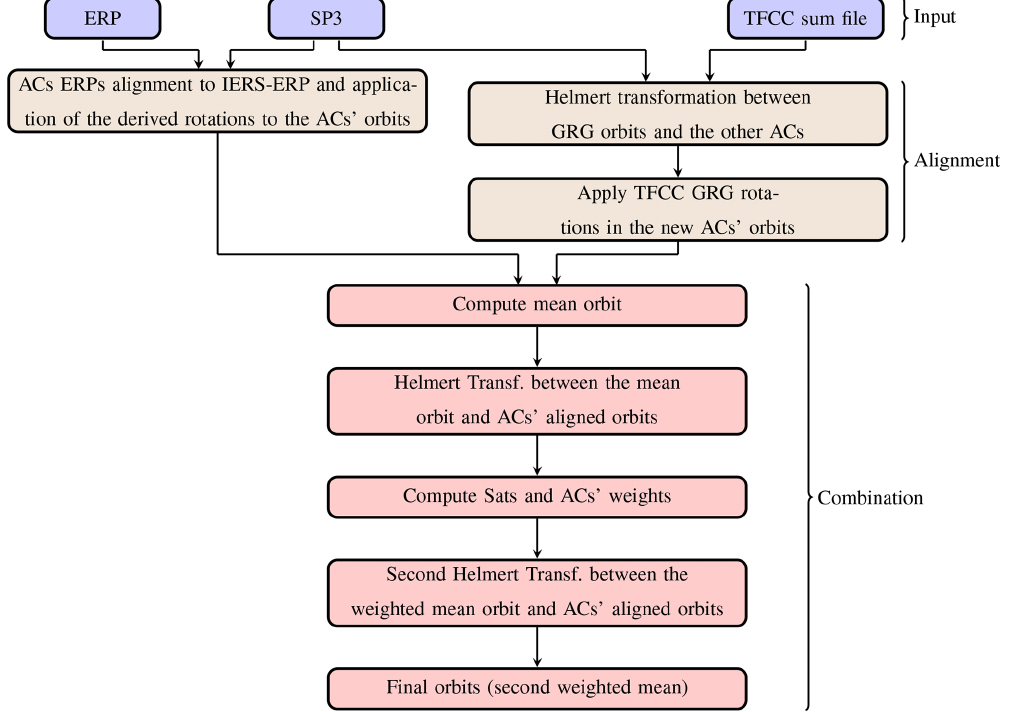
Figure 2. The flowchart presents the generalized steps for both alignment strategies and orbit combination.